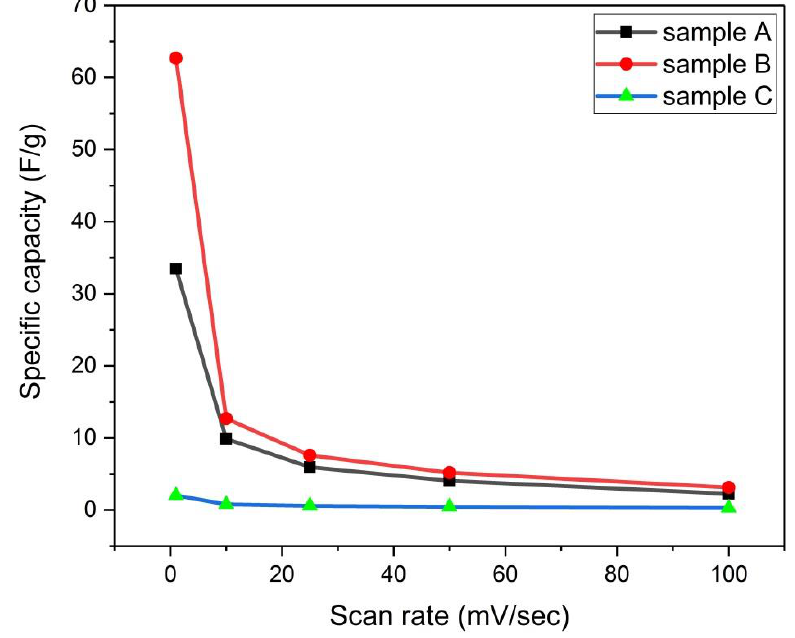
Figure 21. Variation of specific capacity with scan rate for samples (A, B, and C).